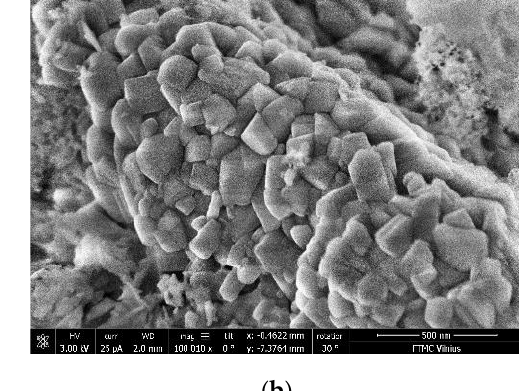
Figure 2. In-situ XRD patterns of synthesis products when the temperature of calcination is 25–1000 ◦ C. Indexes: c—C-S-H(I) / C-S-H(II); w—wollastonite; k—CaCO 3 ; Cr—CaCrO 4 .